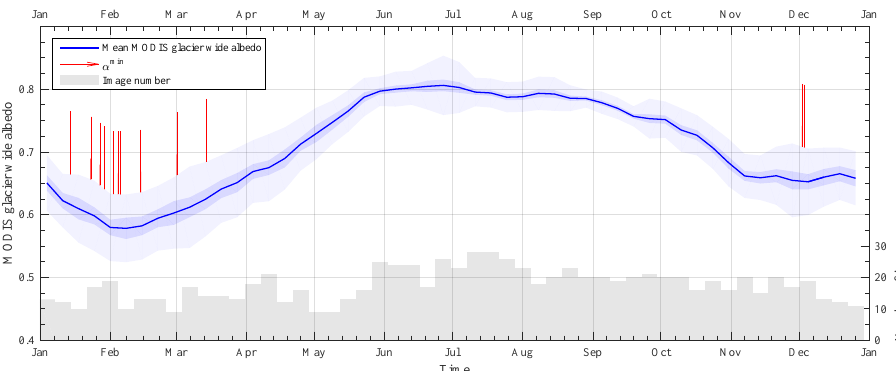
Figure 9. The average seasonal albedo cycle for the study period (2000–2013) presented as a mean weekly glacier-wide albedo. The dates of the annual albedo minima are indicated by the vertical lines. The darker and lighter envelopes around the mean indicate the standard error and standard deviation respectively of the set of observations used to compute the mean.